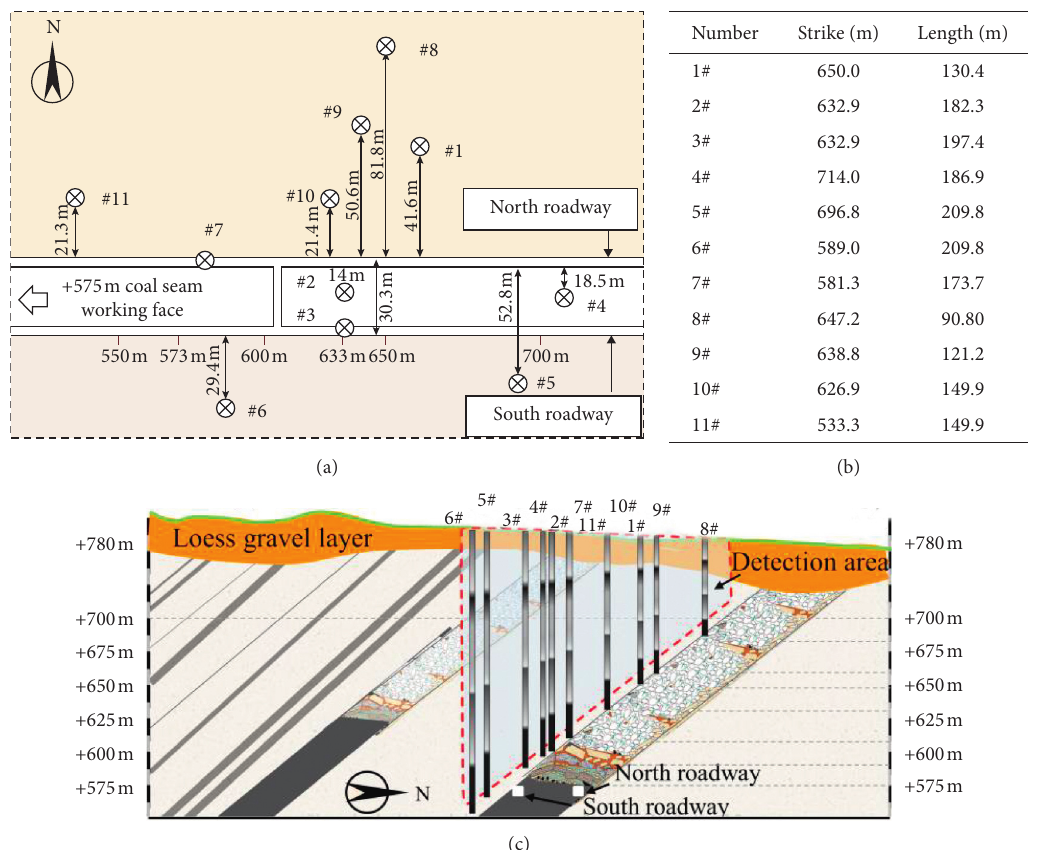
Figure 6: Detection scheme of strata movement: (a) detection hole scheme plane, (b) detection hole parameters, and (c) detection hole scheme section.